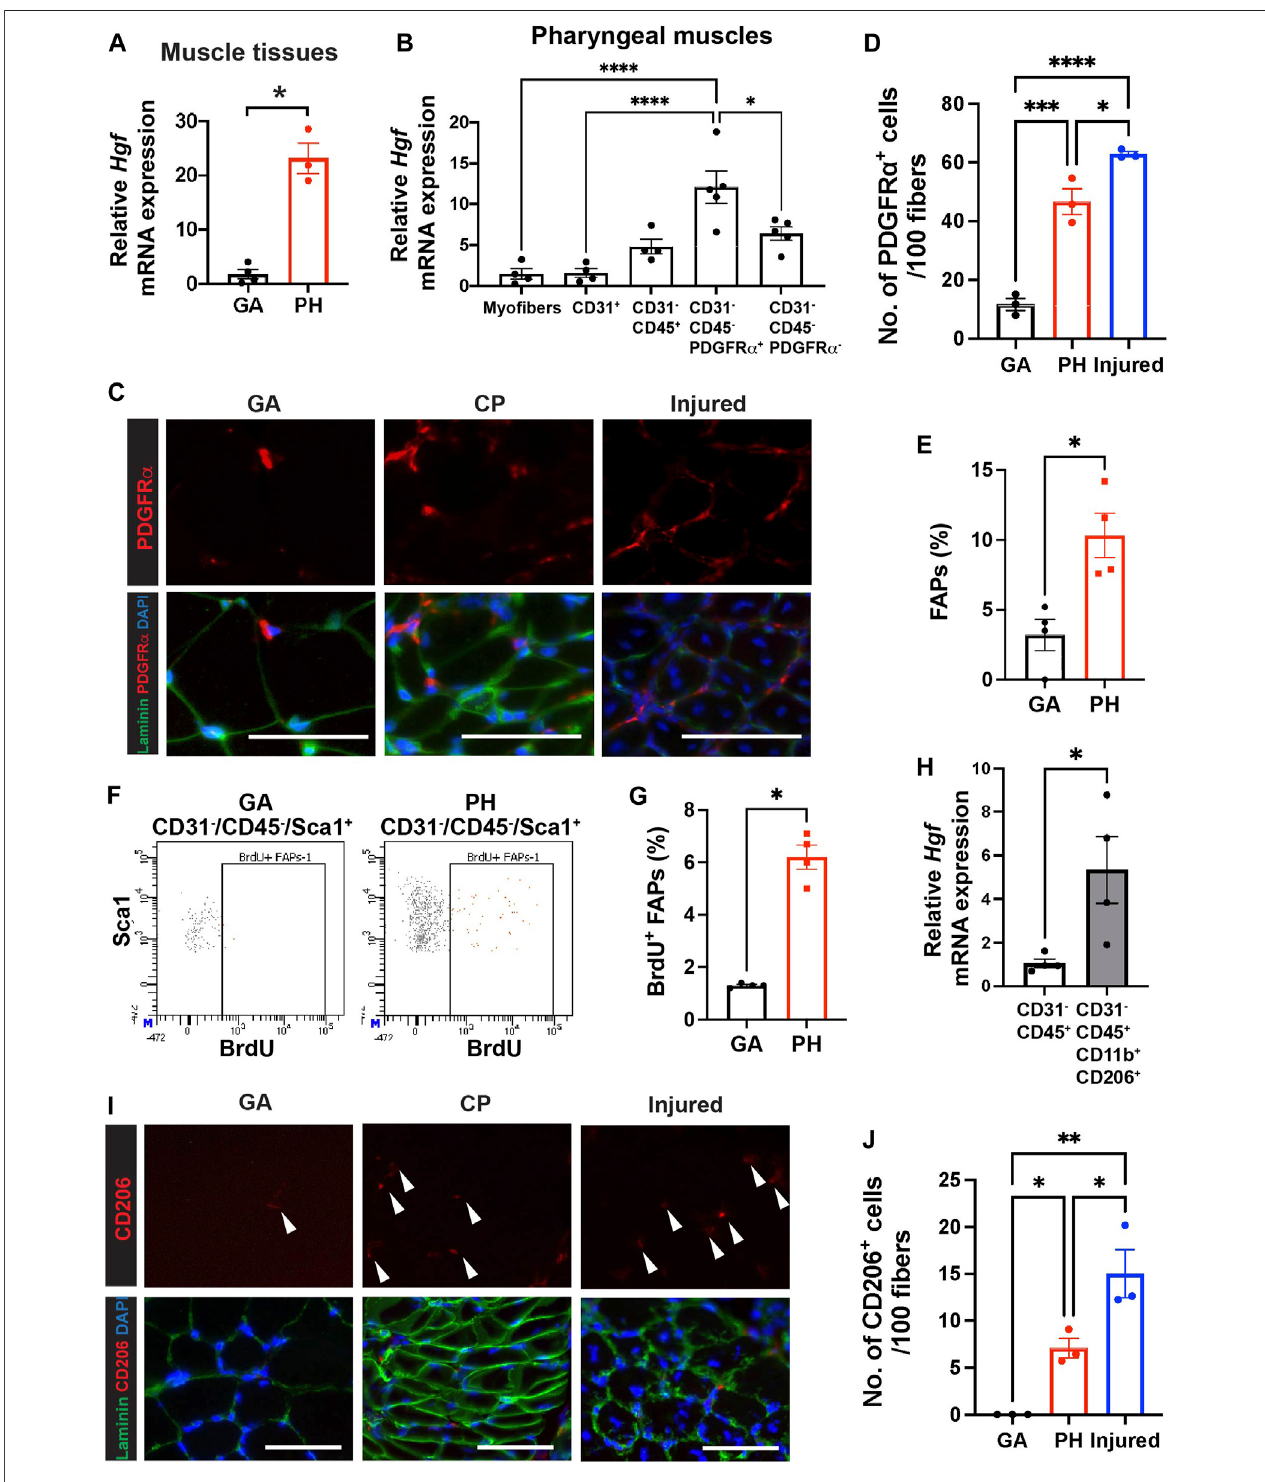
FIGURE3| PharyngealmusclescontainhighlevelofHGF,FAPsandCD206 + macrophages. (A) RelativemRNAexpression levelofhepatocytegrowthfactor( Hgf ) in gastrocnemius (GA) and pharyngeal (PH) muscles obtained from 3 month old C57BL/6 mice. n = 3 – 4. (B) Relative mRNA expression level of Hgf in myo fi bers and MACS-sorted CD31 + , CD31 − /CD45 + , CD31 − /CD45 − /PDGFR α + and CD31 − /CD45 − /PDGFR α − cells obtained from muscles of 3 months old C57BL/6 mice. n = 4 or 5. (C) Representative images of PDGFR α + cells in gastrocnemius (GA) and pharyngeal (PH) muscles of 3 months old C57BL/6 mice. Merged images show immunostaining with anti-PDGFR α (Red) and anti-laminin (green) antibodies and DAPI (blue). Scale bars = 50 µm. (D) Quanti fi ed number of PDGFR α + cells per